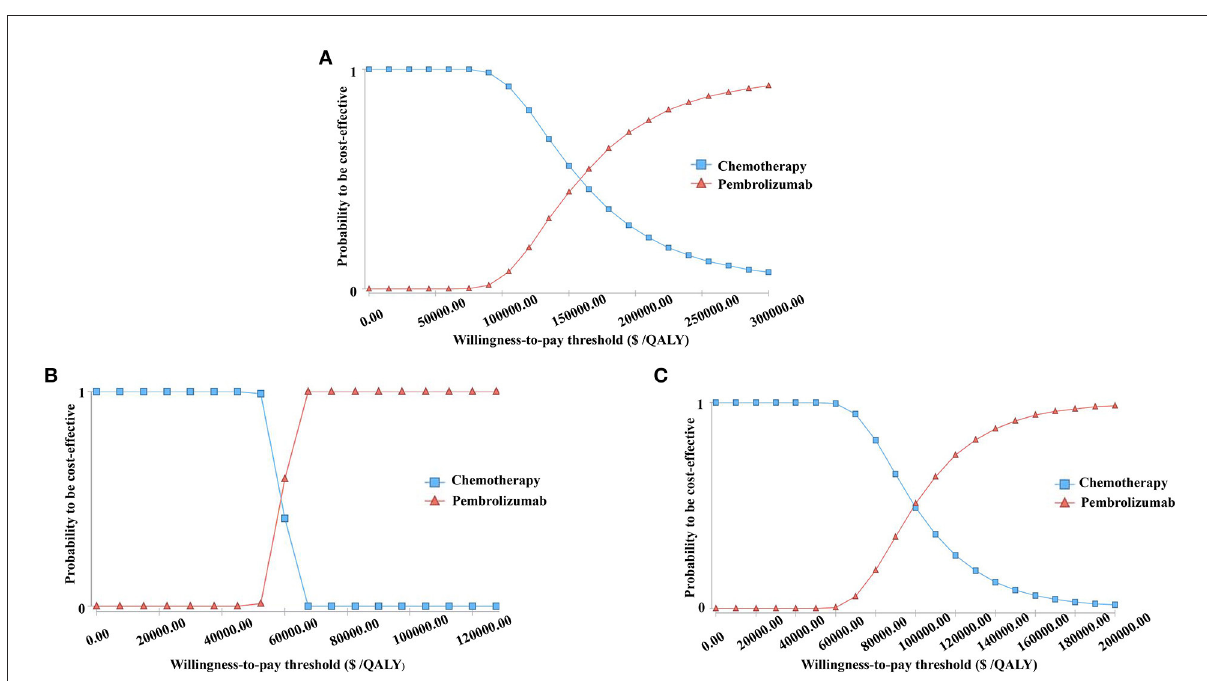
FIGURE3 The cost-effectiveness acceptability curves for the pembrolizumab strategy compared to the chemotherapy strategy in three groups (A) the Intent-to-treat Population; (B) Patients with Squamous Cell Carcinoma; (C) Patients with programmed cell death-Ligand 1 (PD-L1) combined positive score (CPS) ≥